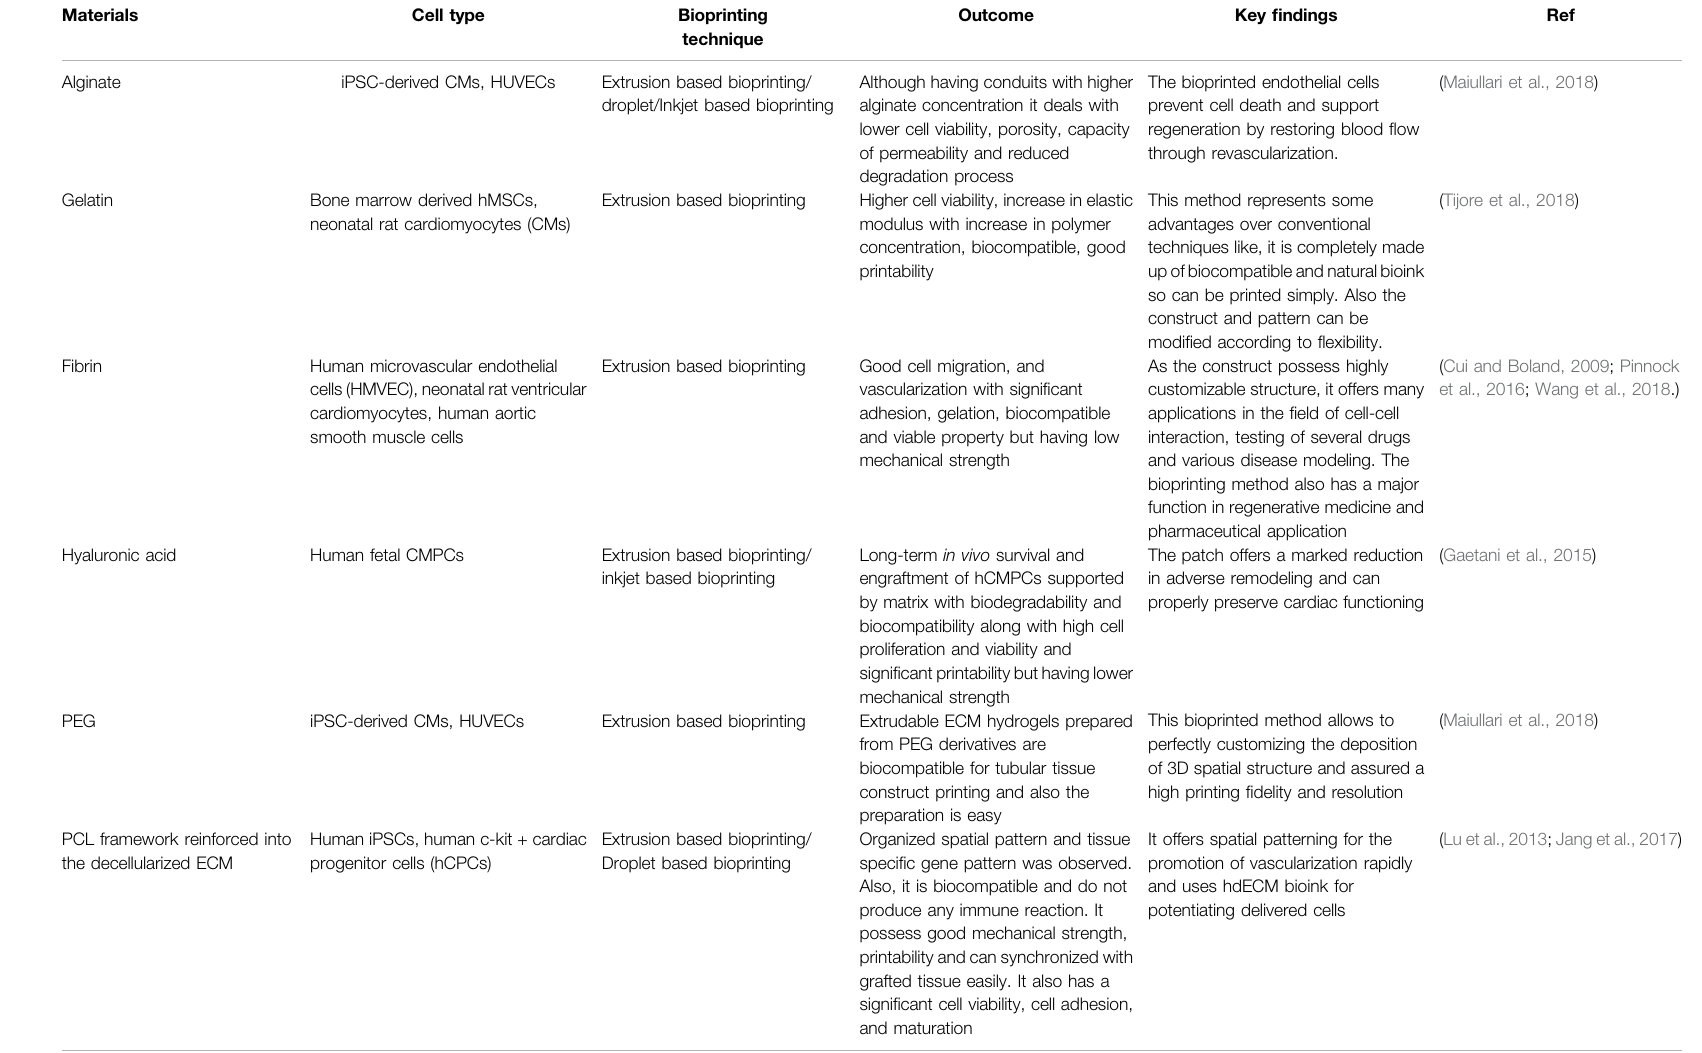
TABLE 3 | Comparative summary of different 3D bioprinting techniques used in cardiac tissue